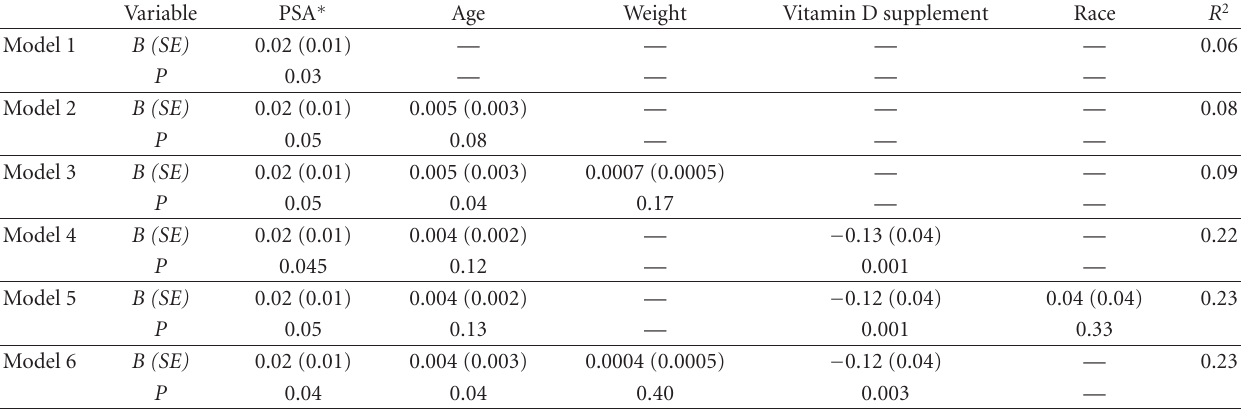
Table 3: Summary of multiple regression analysis for variables predicting spine bone mineral